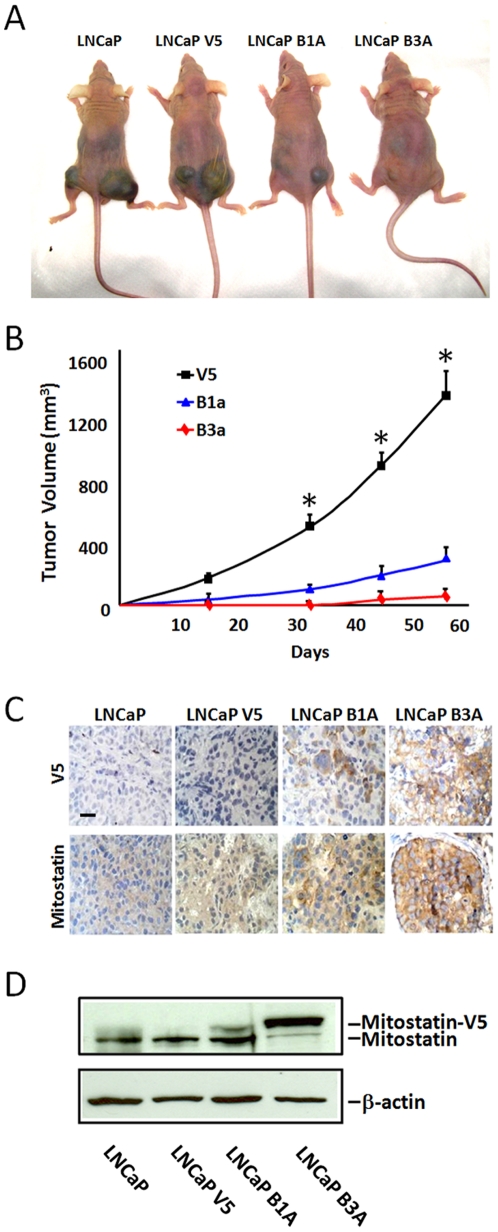
Effects of Mitostatin over-expression on the LNCaP cell tumorigenicity in nude mice.
A: Xenografts established by sub cutaneous injection of LNCaP, LNCaP V5, LNCaP B1A and LNCaP B3A cells in athymic (BALB/c nu/nu) were grown for 65 days. B: Tumor volume in animals injected with cells over-expressing Mitostatin was markedly decreased compared to tumors in animals injected with control cells. The graph illustrates the distribution in tumor sizes formed in BALB/c nu/nu mice through 65 days. *: P<0.05. C, D: Immunohistochemical and immunoblot analysis of Mitostatin expression in LNCaP and derivative tumor xenografts. Immunohistochemistry was performed using both anti-V5 (upper panels) and anti-Mitostatin (lower panels) antibodies. Scale bar: 50 µm.